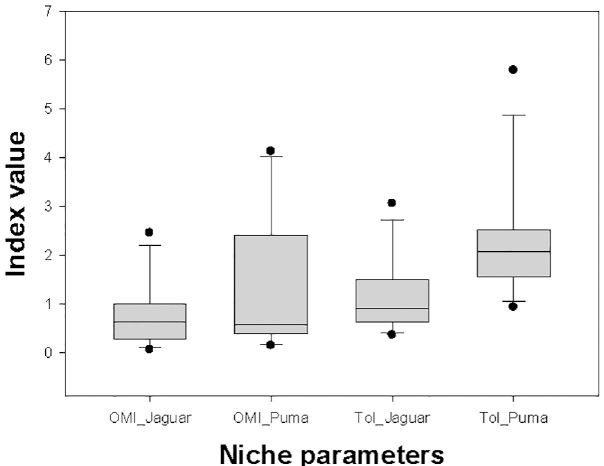
Fig 3. Data dispersion of niche parameters. Boxplots show differences in dispersion of overall data for relevant niche parameters (OMI or marginality, and tolerance, Tol) of jaguars and pumas for the 12 study areas. The box indicates the 25th and 75th percentiles, a line within the box marks the median; error bars indicate the 90th and 10th percentiles, and points values outside the last percentiles. Despite similar OMI median values, variability of puma data is higher than that of jaguars, as predicted under the interference competition hypothesis, with pumas being the subordinate species in the